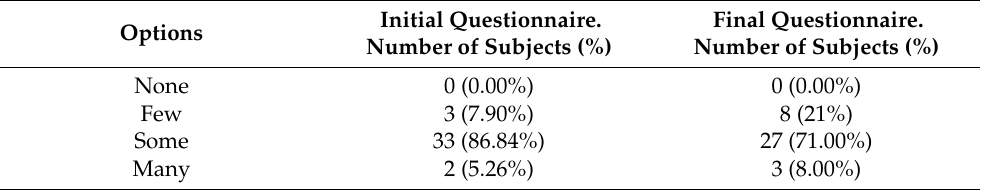
Table 3. Item 1: Changes this new method brings compared to the traditional method when learning how to solve dose calculation problems.